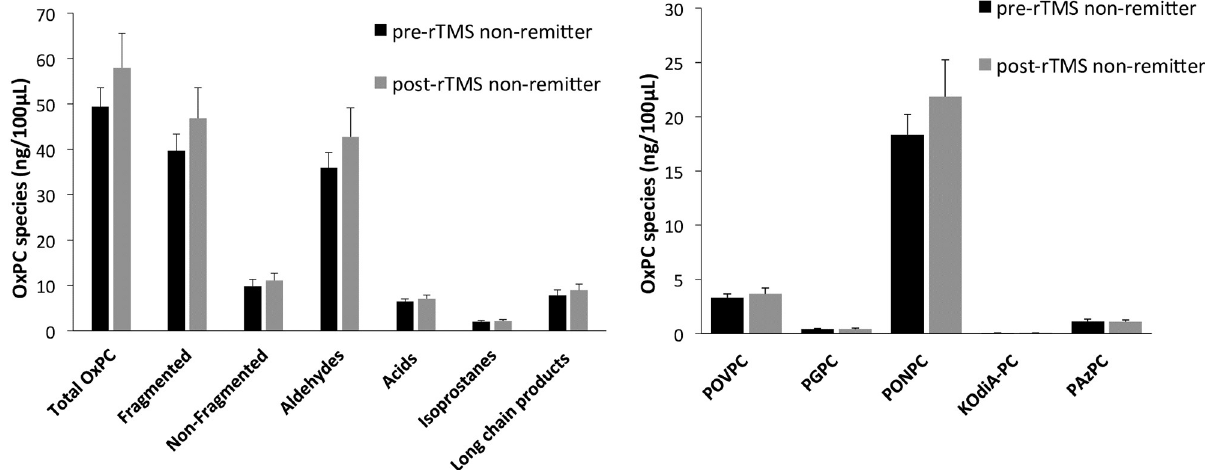
Fig 7. OxPC levels divided into total OxPCs with subgroups [A] and 5 specific OxPC compounds [B] compared between MDD non-remitters pre- rTMS [n = 17] and post-rTMS [n = 17]. Values are mean+SEM.